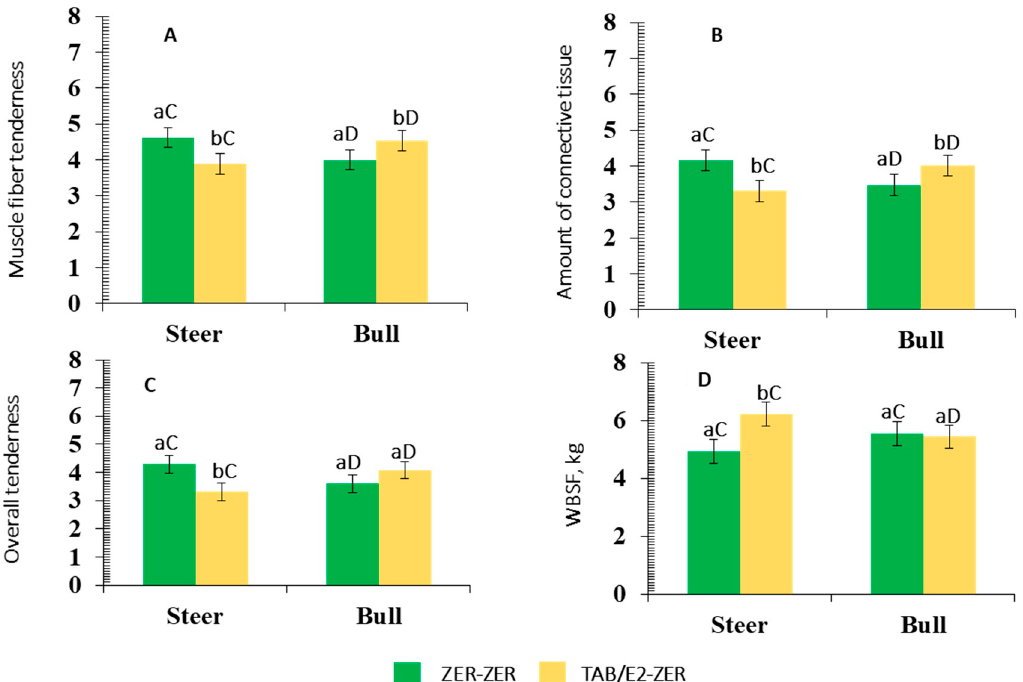
Figure 3. Mean values ± standard error for male class (steer, bull) × implant protocol (IMPL) interaction for muscle fiber tenderness ( p < 0.01; 3A), amount of connective tissue ( p < 0.01; 3B), overall tenderness ( p < 0.01; 3C), and Warner – Bratzler shear force (WBSF, kg) ( p < 0.01;3D). Panelist ratings ( x 1 = extremely tough and 8 = extremely tender; Y 1 = abundant amount of connective tissue, 8 = no connective tissue). IMPL: ZER ‐ ZER: corresponds to a dose (72 mg) of zeranol at d ‐ 0 followed by a second identical dose at d ‐ 90; TBA/E2 ‐ ZER: corresponds to a first dose containing 140 mg trenbolone acetate + 20 mg estradiol benzoate at d ‐ 0, followed by a second dose of zeranol (72 mg) at d ‐ 90. Bars with a common superscript lowercase letter (a, b) for IMPL treatments within the same male class do not differ ( p > 0.05). Bars with a common superscript uppercase letter (C, D) for male classes within the same IMPL, do not differ ( p > 0.05).